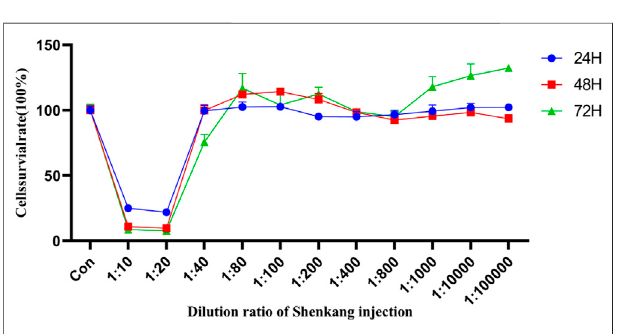
FIGURE 8 | Effect of Shenkang injection with different dilution on HK-2 cell